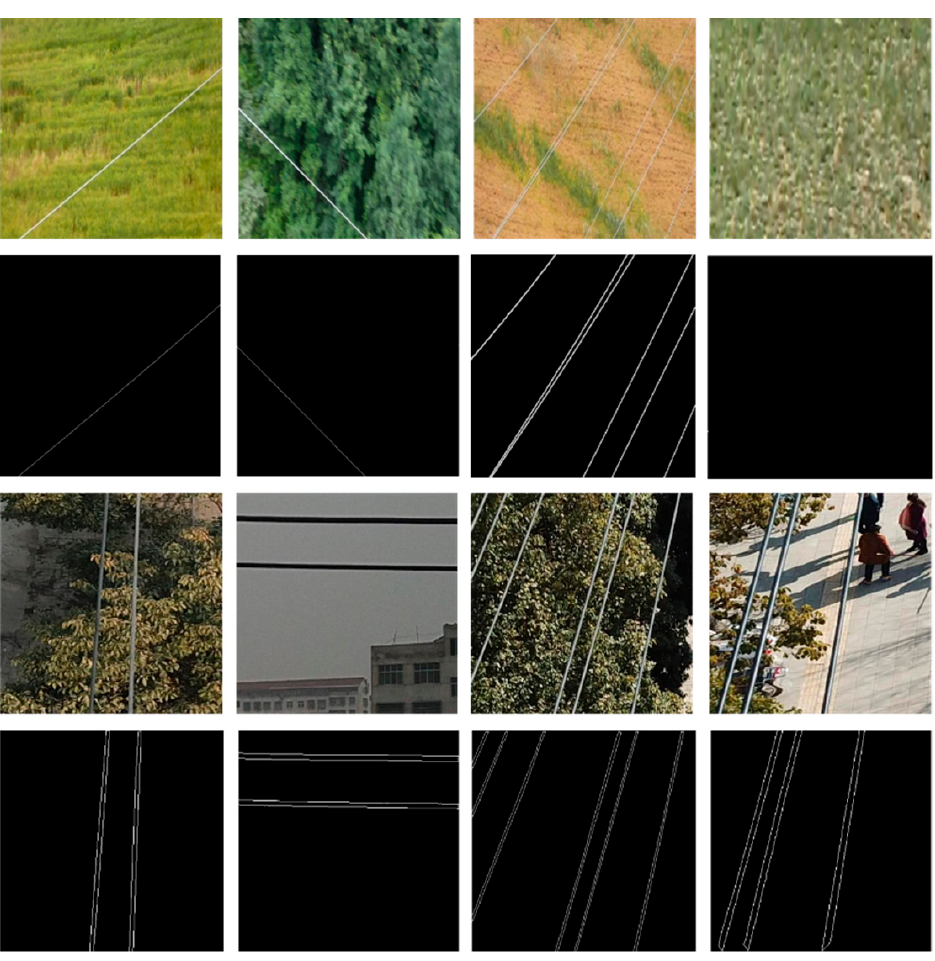
Figure 2. Example images of power lines and their corresponding ground truth annotations from the PL benchmark datasets. Top two rows: Mendeley PL dataset [39]; bottom two rows: PLDU [40]. The PL detection task is framed as a binary semantic segmentation problem with the aim of accurately classifying and localizing the minority class PL pixels against the majority class background pixels. Since the size of the datasets is rather small for training a deep segmentation network, the following on the fly data augmentations are applied to the images in both the training